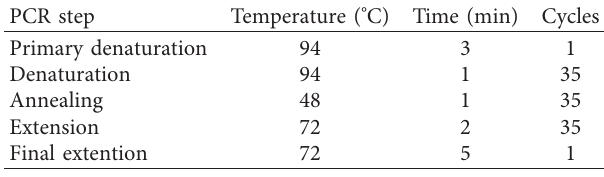
Table 1: ERIC-PCR protocol.